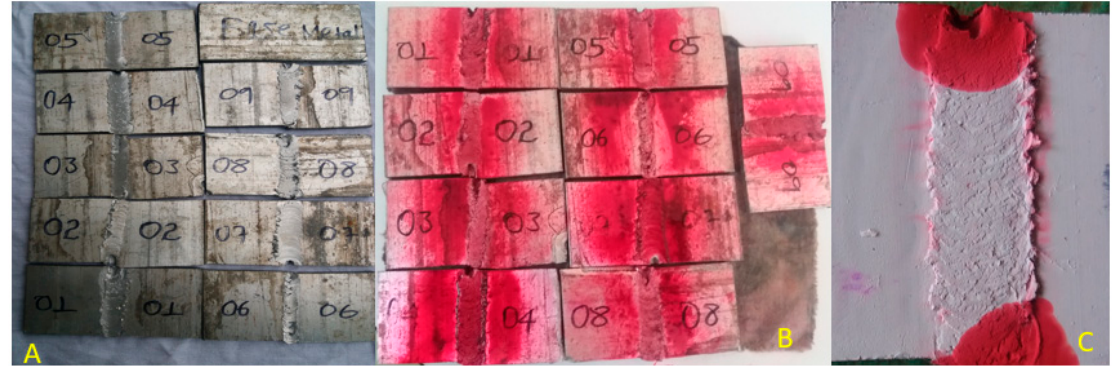
Figure 8. Liquid penetrant test: ( A ) Welded specimens before the liquid penetrant test; ( B ) welded specimens after applying penetrants on the faying surfaces; ( C ) welded specimens after applying developer.